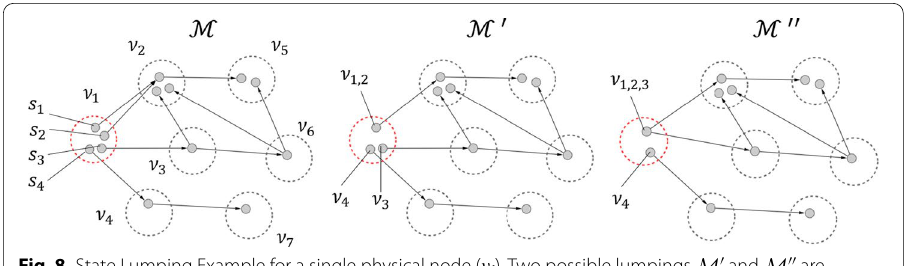
Fig. 8 State Lumping Example for a single physical node ( ν 1 ). Two possible lumpings M ′ and M ′′ are visualised here over the state nodes (grey nodes) with the physical node mapped over (dotted circles surrounding state nodes). Here each lump merges the two most similar state nodes based on feature vectors capturing local visitation probabilities of k = 2 network